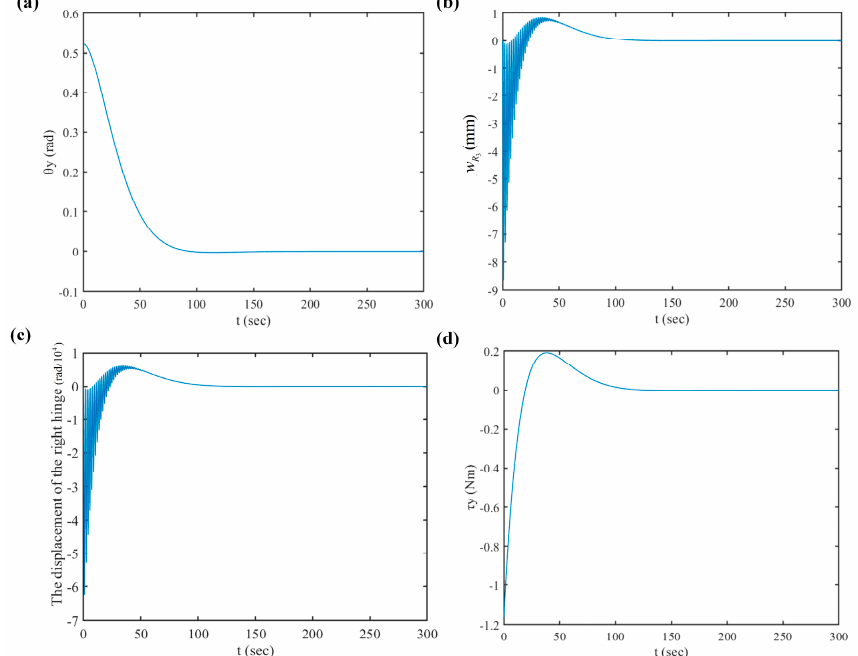
Figure 15. Time responses of the flexible spacecraft for using the LQR control ( k = 500 N · m/rad); they are listed as: ( a ) the displacement of θ y ; ( b ) the displacement of the 3rd-right panel tip; ( c ) the displacement of the right hinge B R